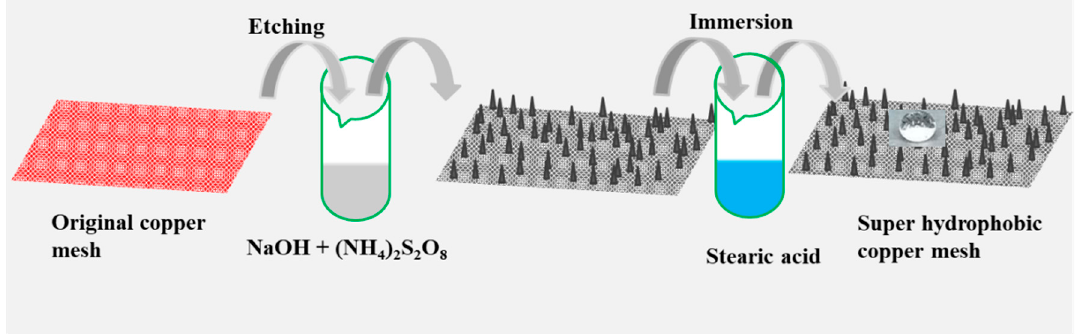
Figure 1. Fabrication of the super-hydrophobic copper mesh.